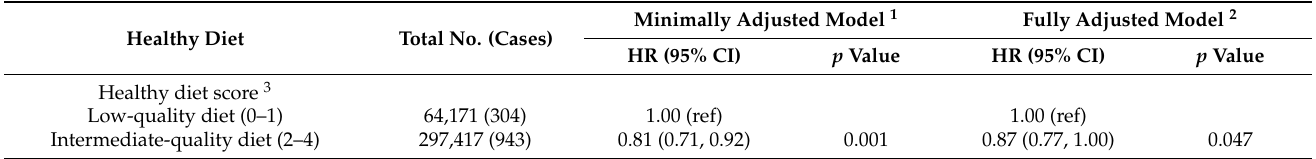
Table 2. Associations between healthy diet score and the risk of UGI